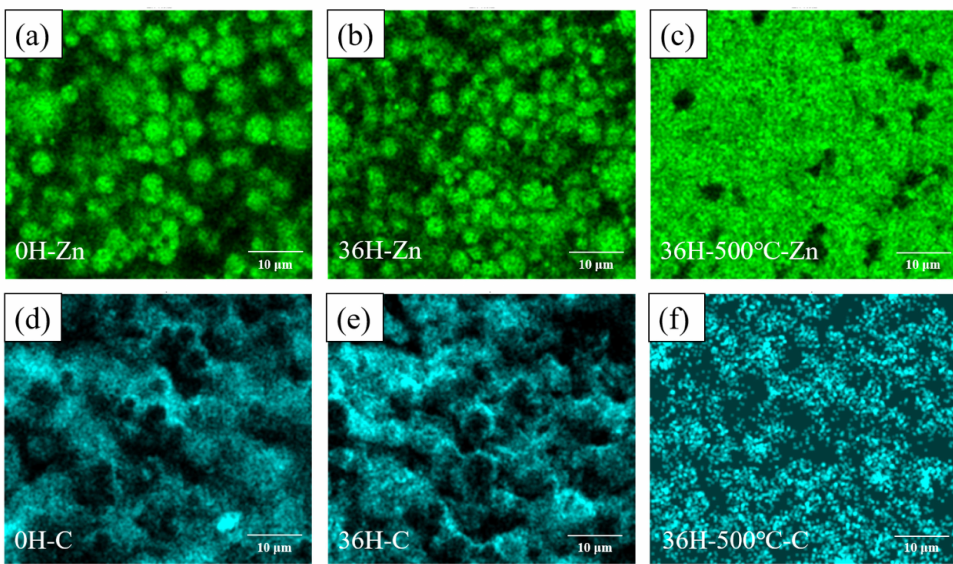
Figure 10. EDS zinc maps of the coatings ( a ): 0H, ( b ): 36H and ( c ): 36H-500 ◦ C. EDS carbon maps of the coatings. ( d ): 0H, ( e ): 36H and ( f ): 36H-500 ◦